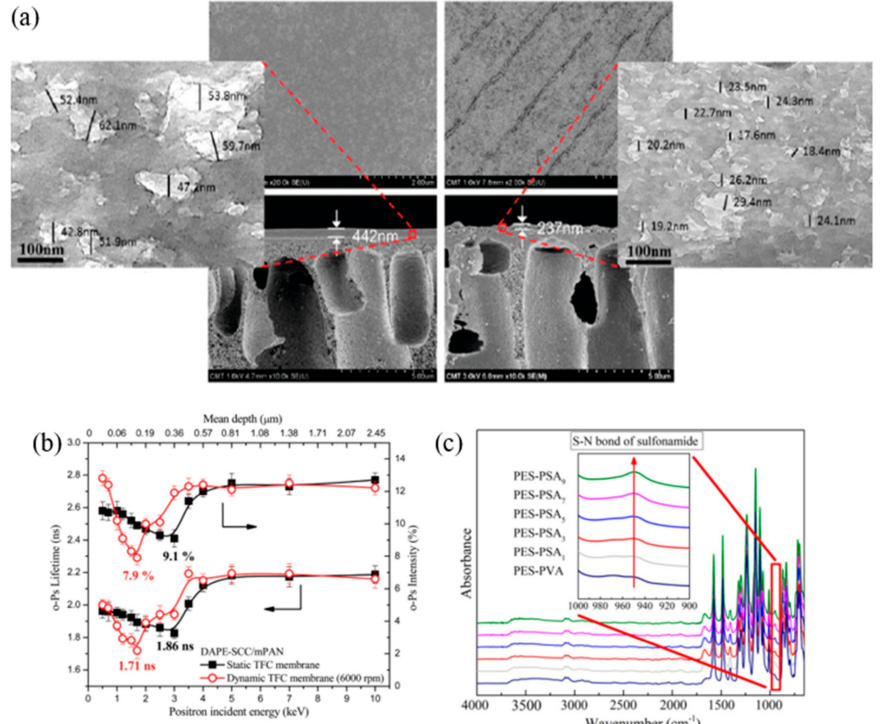
Figure 8. ( a ) Cross-sectional SEM images of conventional IP (left) and spin IP (right) membranes [95], ( b ) o-Ps intensity vs. positron incident energy for membranes fabricated through conventional IP and spin IP technique [95] and ( c ) ATR-IR spectra of spin-based multilayer IP (number represents deposited layer number)